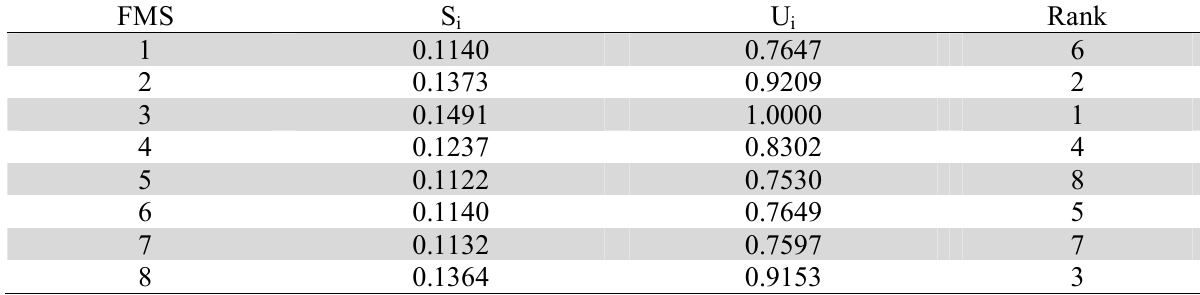
S and U values in ARAS i i